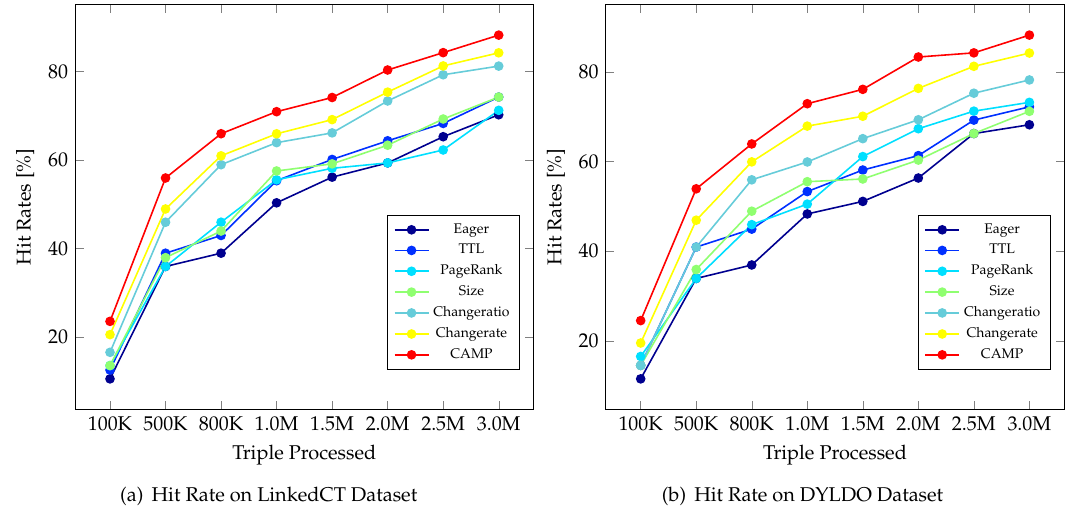
Figure 5. Hit Rate achieved by CAMP as compared to existing